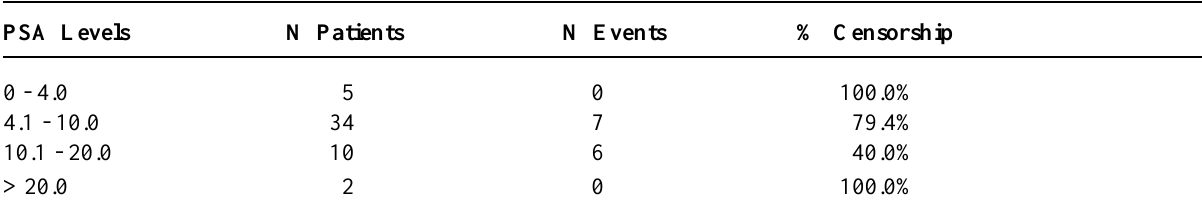
Table 3 – Distribution of patients with clinical stage T1c and Gleason scores 7 - 8, according to PSA levels.